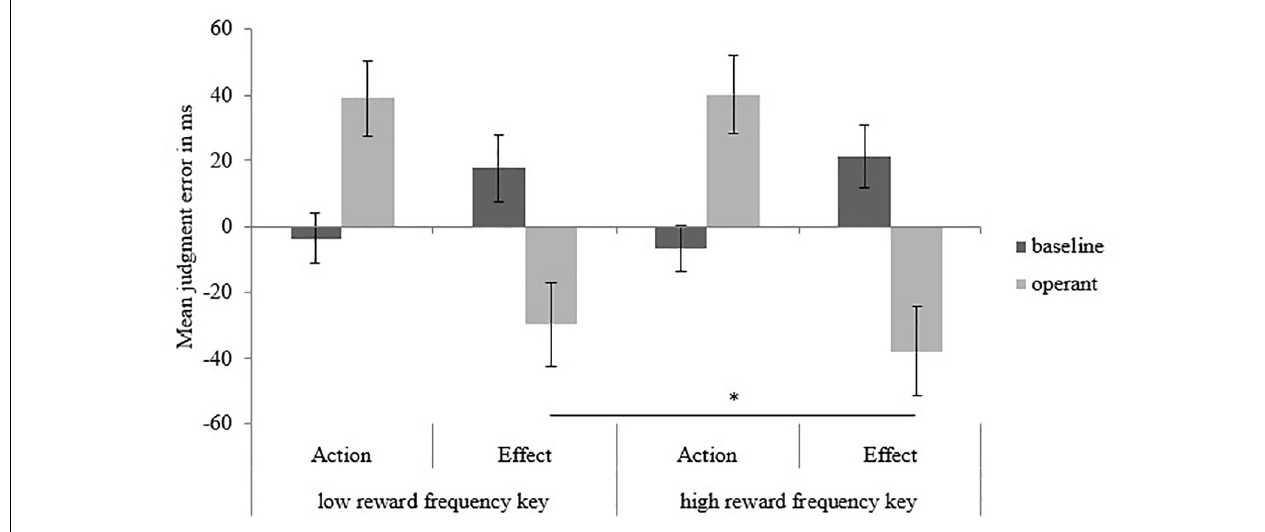
FIGURE 1 | Mean judgment errors in ms for action and effect across type of trial and reward frequency of the key. Bars represent standard errors of the mean. ∗ p =